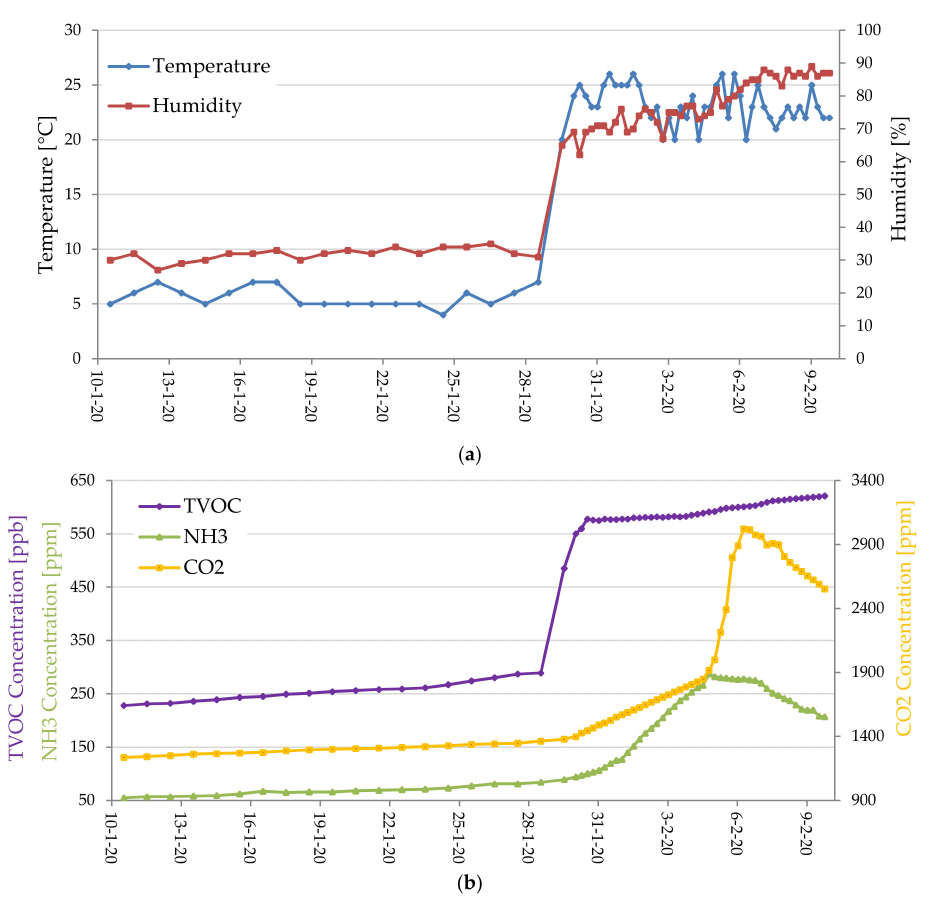
Figure 22. Temporal trends of the parameters detected by the BLE tag applied to the plastic box with 5 kg of oranges inside, during 30-day-long period. ( a ) Temperature and humidity; ( b ) TVOC, NH 3 and CO 2